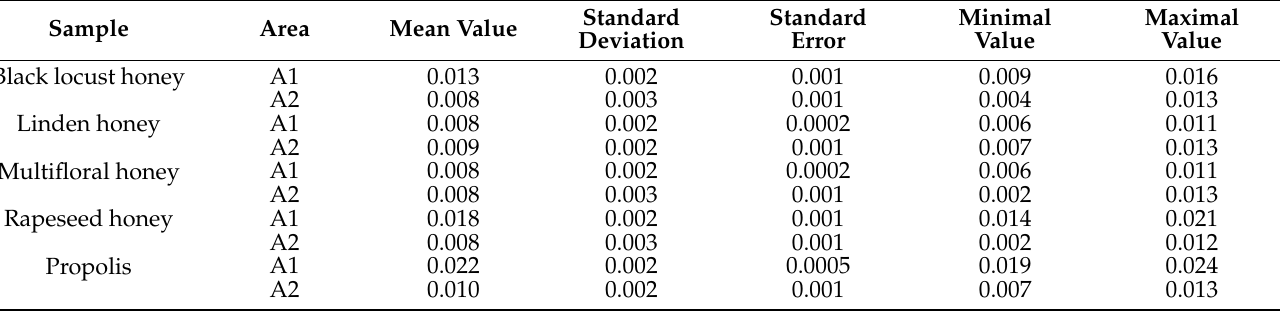
Table 6. Bioconcentration factor for Cd.